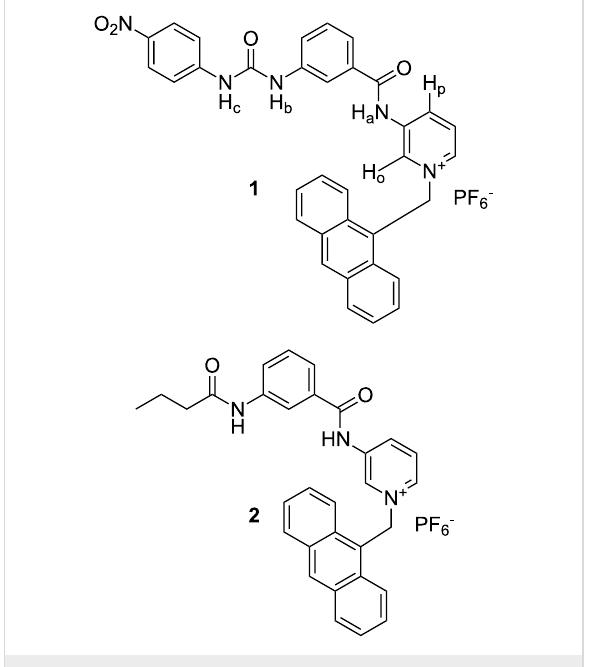
Figure 1: Synthesized compounds 1 and 2 .